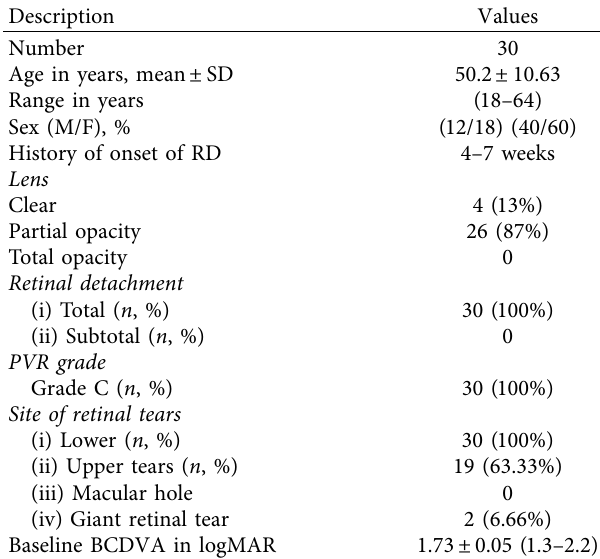
Table 1: Preoperative